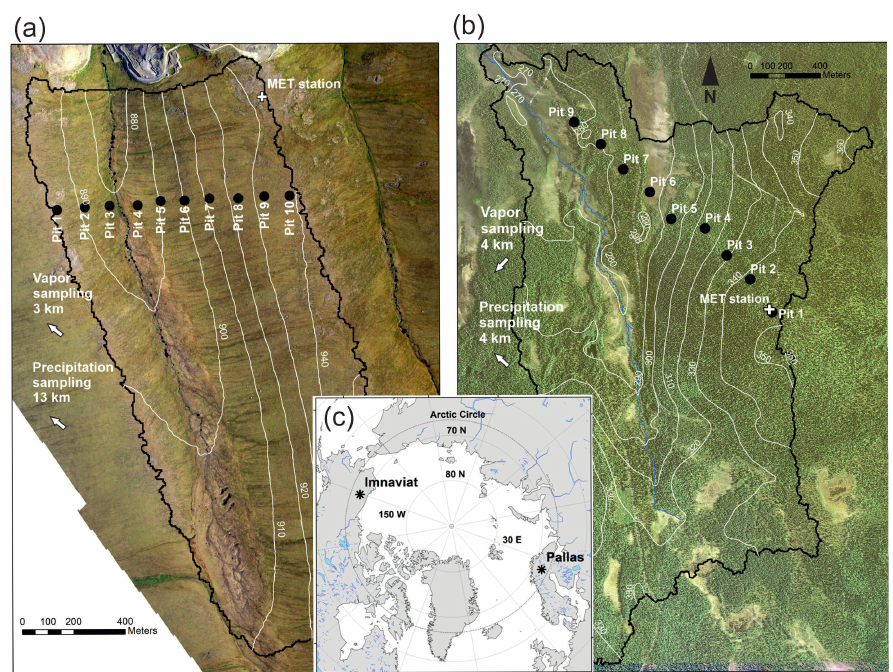
Figure 1. Locations of snowpit sampling, meteorological stations, and indication of precipitation and vapor sampling locations in the ( a ) Imnavait and ( b ) Pallas study sites. Subfigure ( c ) shows the site locations at the opposite sites of the